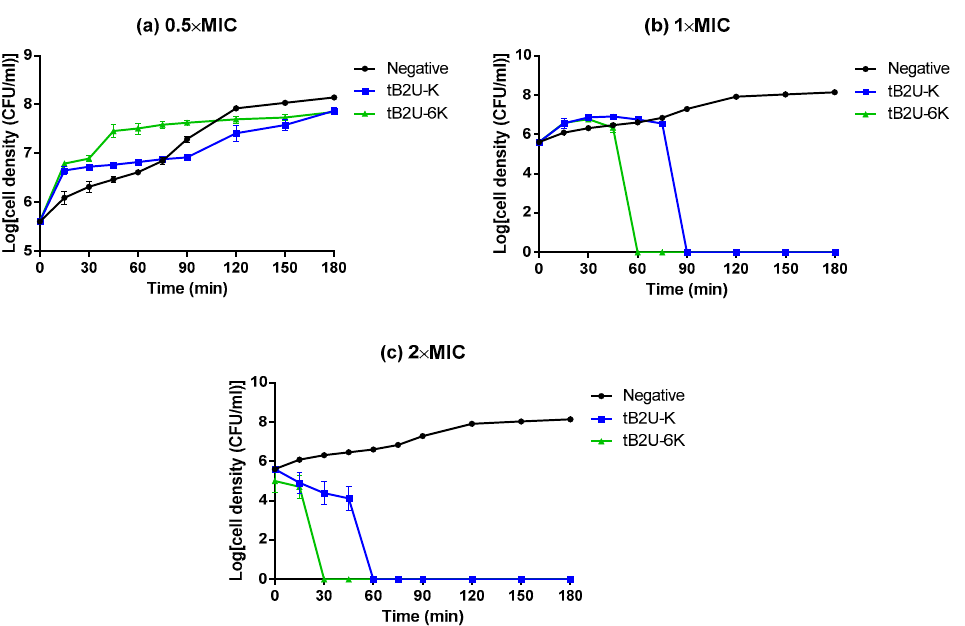
Figure 6. The kinetic time-killing curves of tB2U-K (blue) and tB2U-6K (green) at the concentrations of ( a ) 0.5 × MIC (16 µM), ( b ) 1 × MIC (32 µM) and ( c ) 2 × MIC (64 µM). The bacteria treated with MHB medium only is used as the negative control. The error bar represents the SEM of the three replicates from three independent tests.